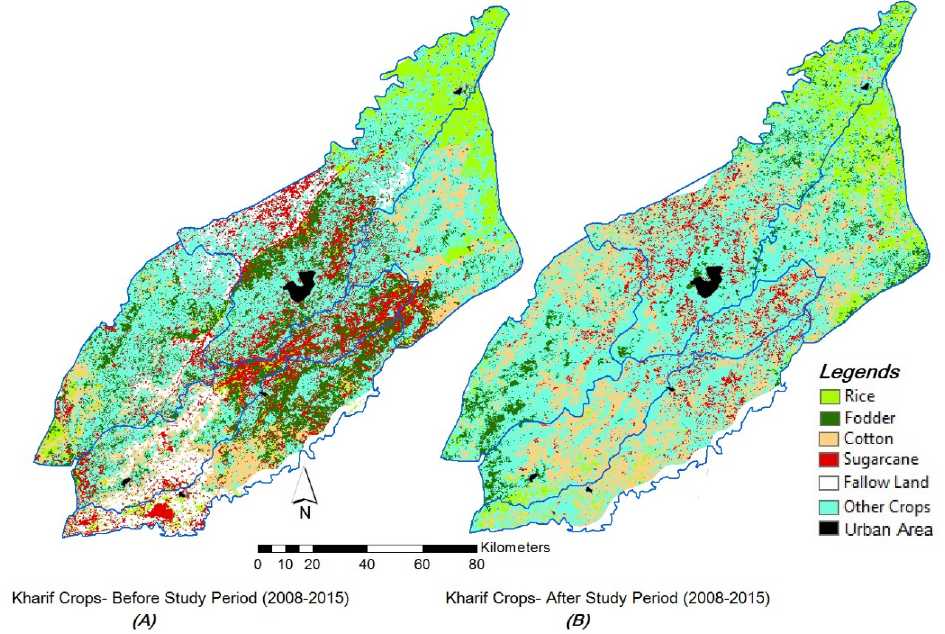
Figure 4. Land use change in the Kharif Crops ( A —before study period, B —after study period).